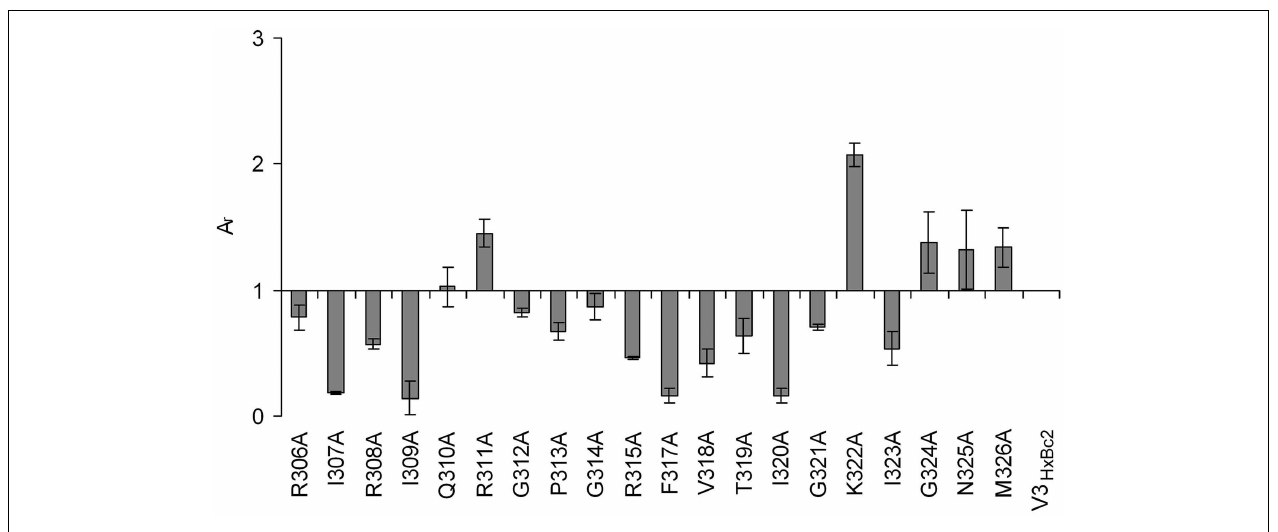
calculated according to the following formula: A r = ( A peptide − A blank )/( A c − A blank ), in which “peptide” refers to the respective variant ofV3 HxBc2 , and “c” refers to V3 HxBc2 . Error bars present deviations from the